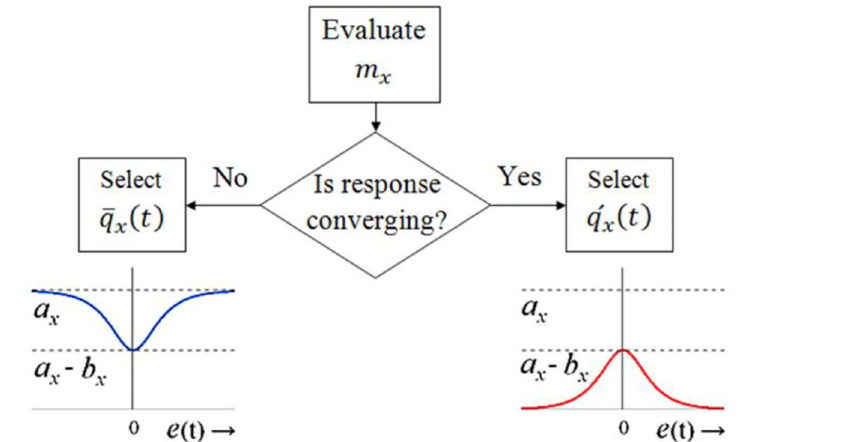
Fig 8. Self-mutation scheme for weight-adjusting functions.